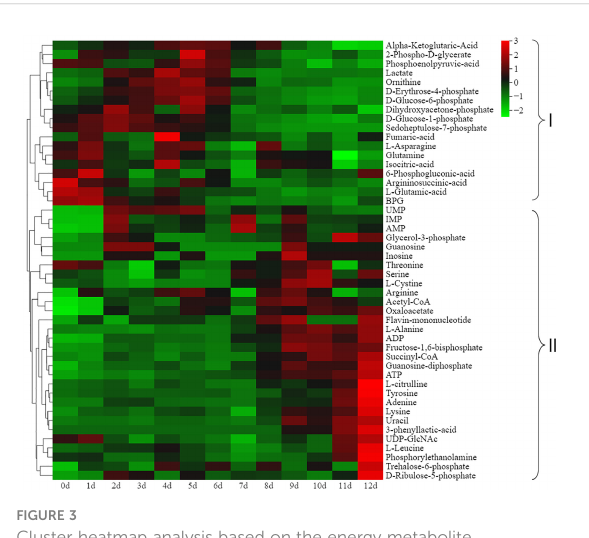
FIGURE 2 Cluster heatmap analysis based on organic acid accumulation levels at different ripening stages. Organic acids in group I gradually decreased during ripening, while organic acids in group II gradually increased during ripening.